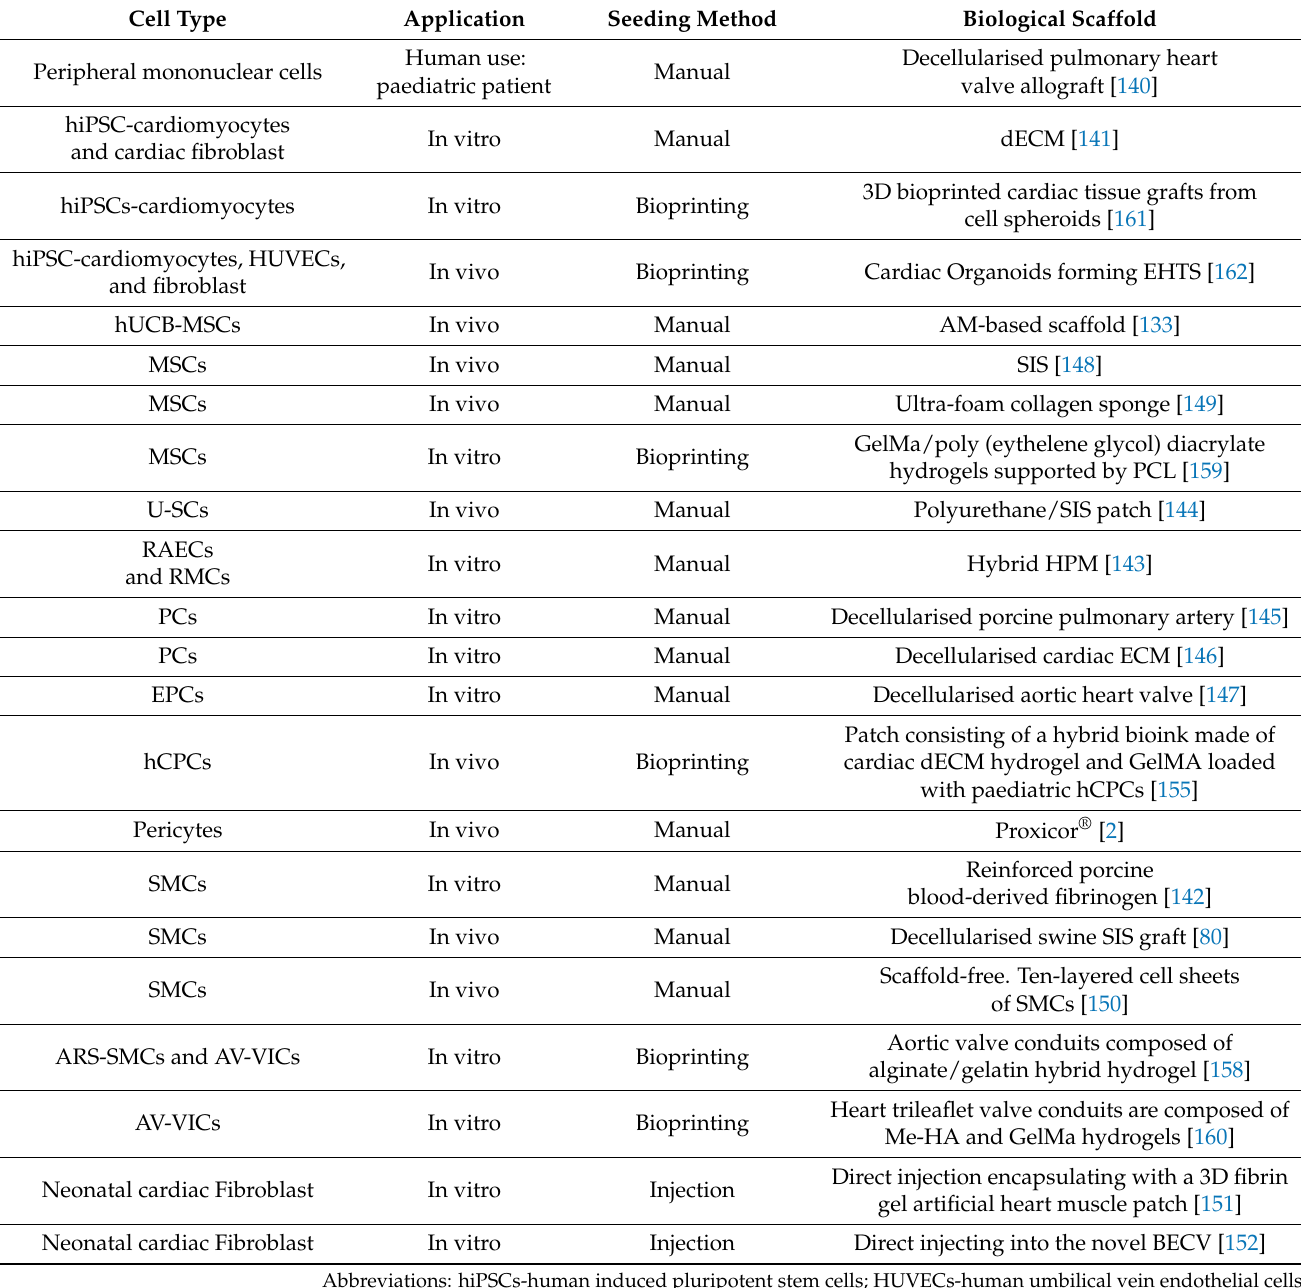
Table 3. Summary of cell types used for cellularisation of biological